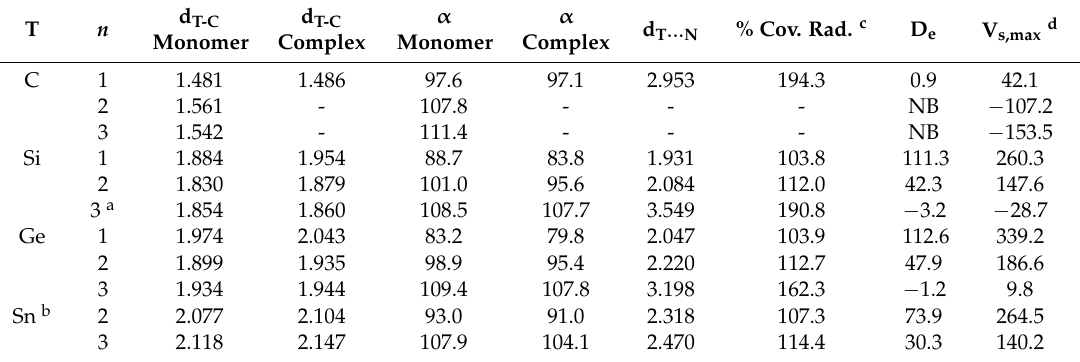
Table 3. Bond distances, angles, dissociation energies, and V s.max of 2 T n , and their binding complexes with HCN (distances in Å , energies in kJ mol −1 ).